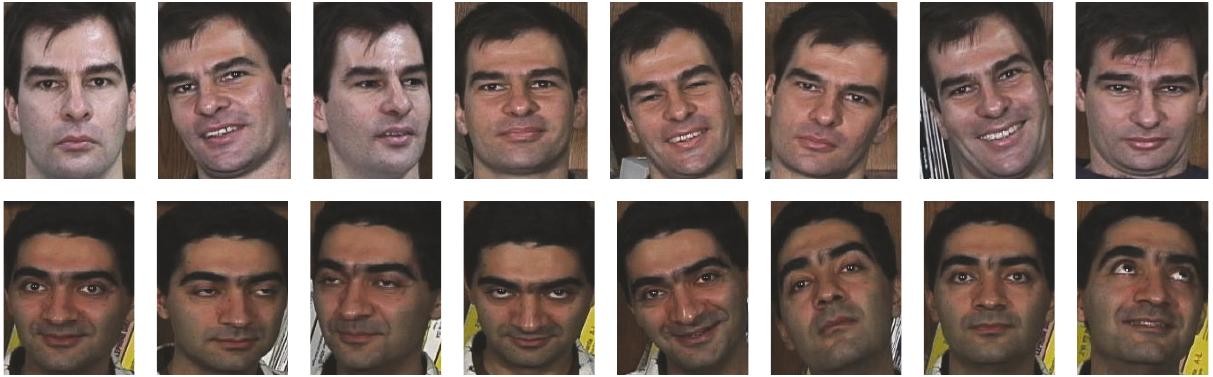
Figure 1: Some face images from the GT face database.